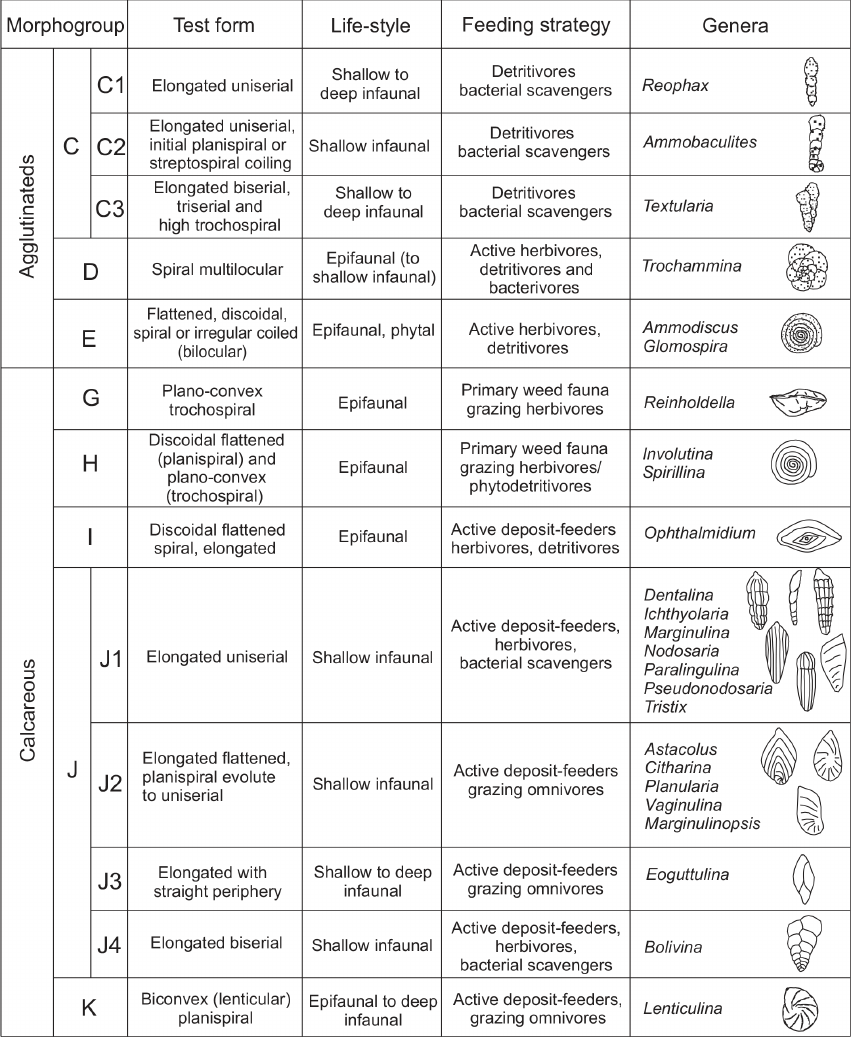
Figure 3. Calcareous foraminiferal morphogroups for the upper Pliensbachian–lower Toarcian sediments of Cueva del Agua (based on Reolid et al., 2008, 2012a; Rita et al.,